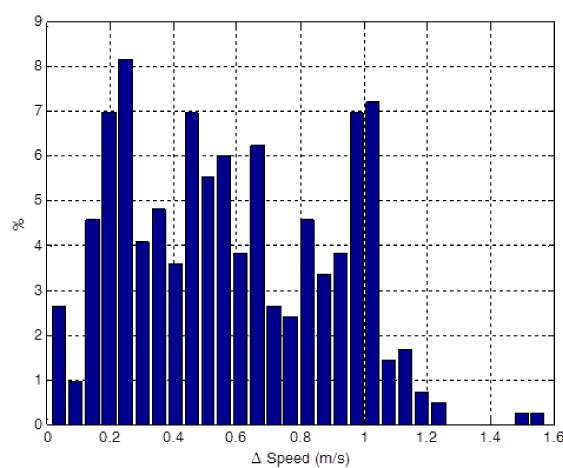
Figure A6. Speed